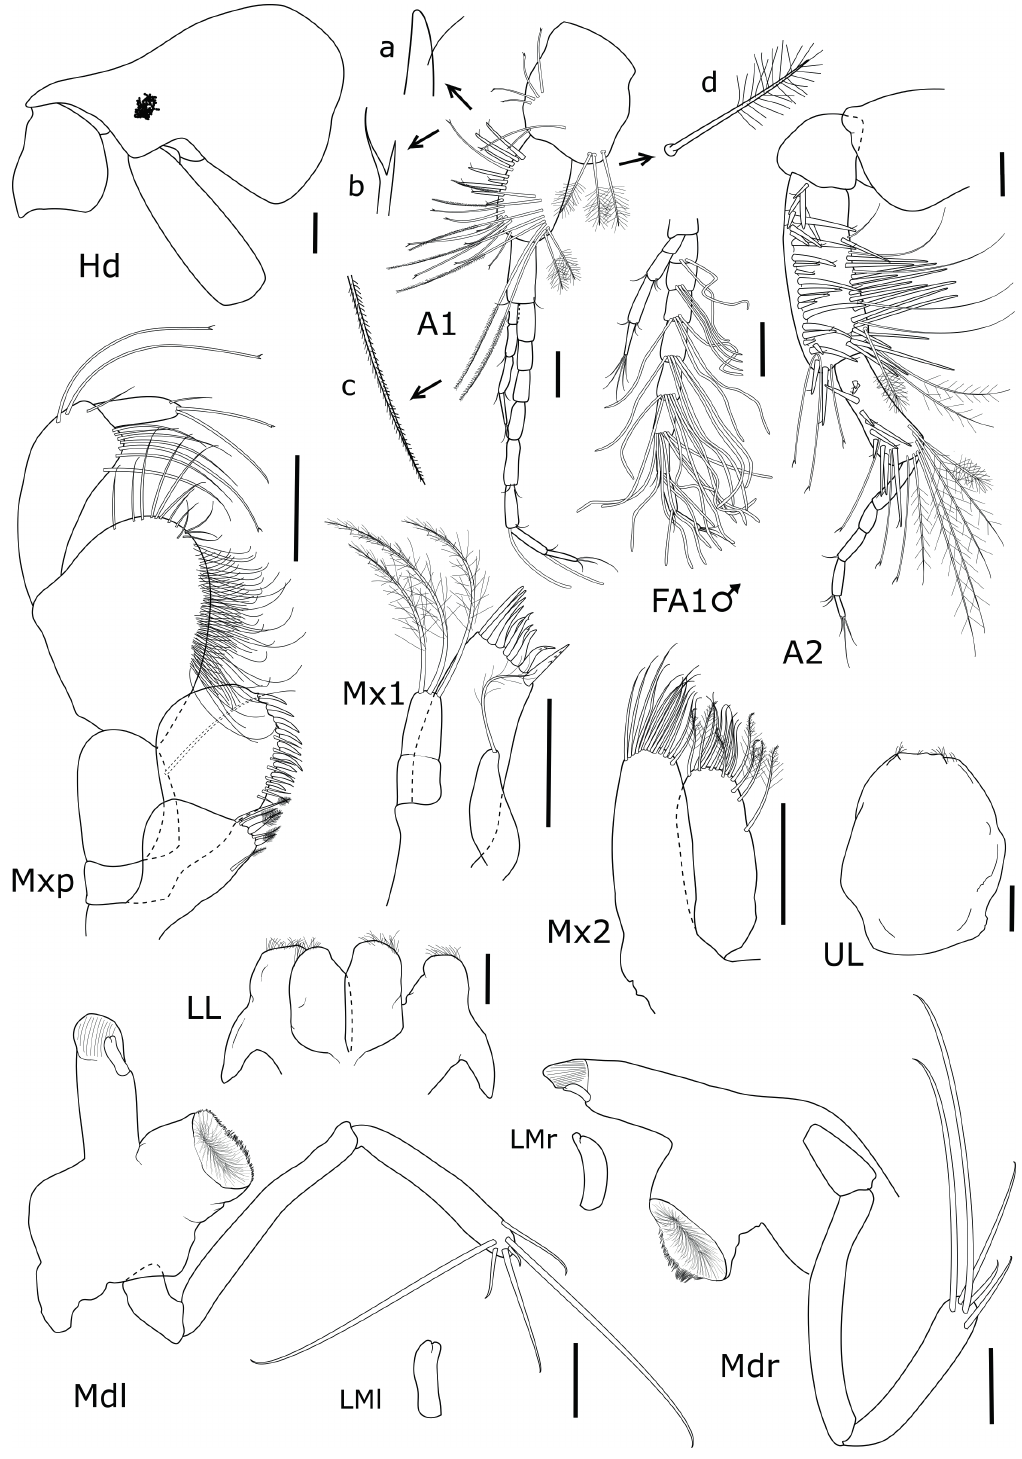
Figure 9 - Puelche longidactylus sp. nov. Female, 5.0 mm, MNRJ 28746: Head, antennae and mouthparts. Male, 2.9 mm, MNRJ 28747: Flagellum of antenna 1. Detailing of setae of antenna 1: a . robust seta with accessory seta; b . simple seta with lamellate tip; c . plumose seta with small setules; d . penicillate seta. Scales = 0.1